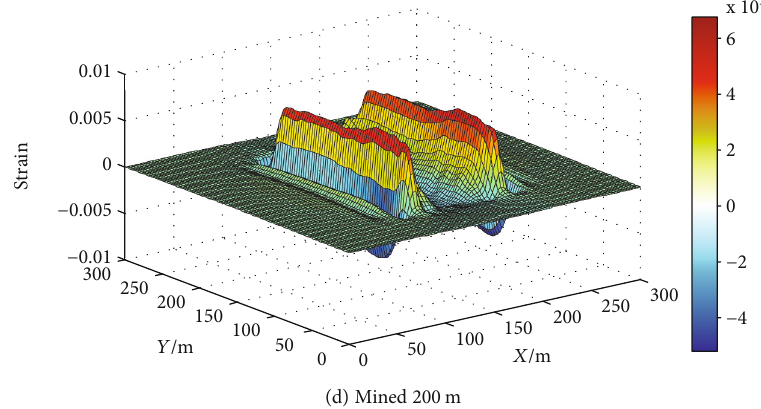
Figure 3: X -direction strain of protected coal